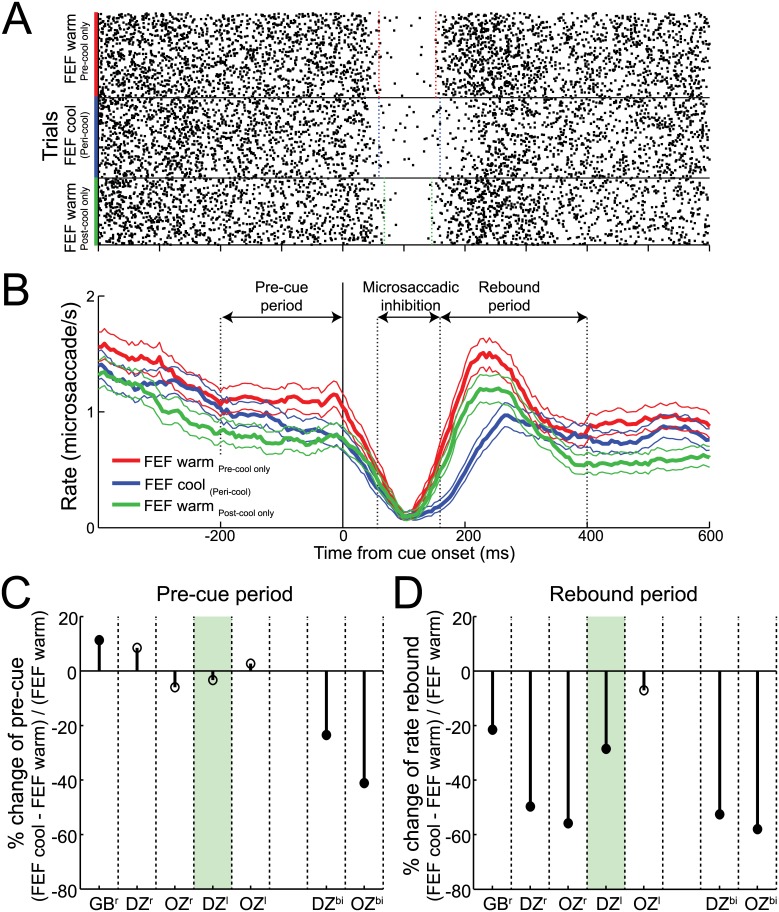
FEF inactivation markedly reduced microsaccades in the rebound period.(A) Microsaccade onset times relative to cue onset for individual pre-, peri-, and post-cooling trials from our example monkey with a unilateral (left) FEF inactivation. Each dot is a microsaccade onset time, and each row is a trial. (B) Corresponding time-courses of mean microsaccade rate (+/- 95% confidence intervals) for each of the pre-, peri-, and post-cooling sessions. In our example monkey, unilateral FEF inactivation exerted its greatest impact on microsaccade rate during the rebound period (i.e., 140–400 ms after cue onset), with no changes occurring in the pre-cue period (i.e., 200 ms period before cue onset) or the microsaccadic inhibition period (i.e., 60–140 ms after cue onset). (C) Across monkeys, we found consistent microsaccade rate decreases in the pre-cue period with bilateral but not unilateral inactivation configurations. (D) In contrast, both unilateral and bilateral FEF inactivation consistently decreased microsaccade rate in the rebound period. Same format as Fig 2C. Data in Supporting Information (see S3 Data).